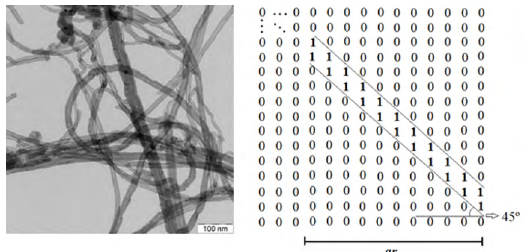
Figure 4. (a) Morphology and (b) Scheme of volume representation of CNT structure in simulator perspective.